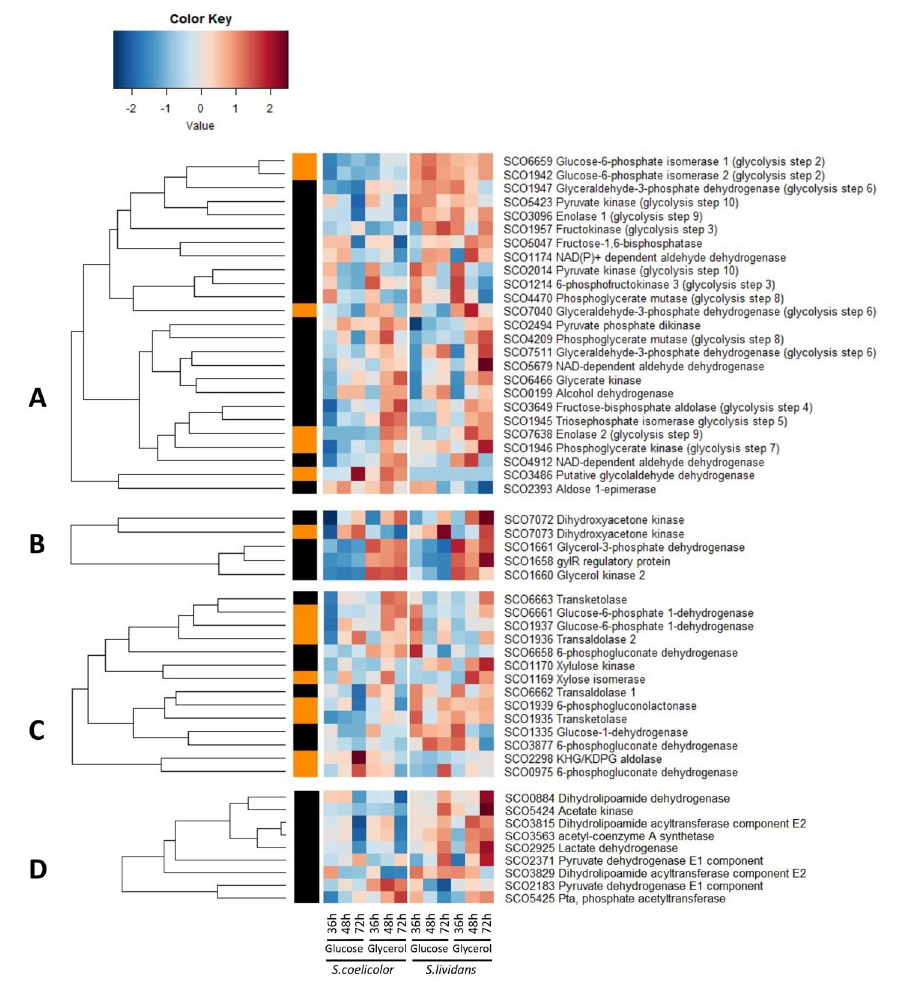
Figure 4. Independently generated heatmap representations of proteins belonging to central carbon metabolism pathways with significant abundance change (ANOVA, adjusted p value < 0.05) between S. coelicolor (M145) and S. lividans (TK24) with either glucose or glycerol as main carbon source, for 36, 48 and 72 h. Proteins belonging to glycolysis/gluconeogenesis (A) ; glycerol metabolism (B) ; Pentose Phosphate Pathway (C) ; AcetylCoA generation and over-flow metabolism (D) . Protein identifiers are indicated as SCO numbers for both strains and by predicted functions. The quantification methods are displayed in the vertical bar indicating proteins quantified by Spectral Counting (orange) or XIC